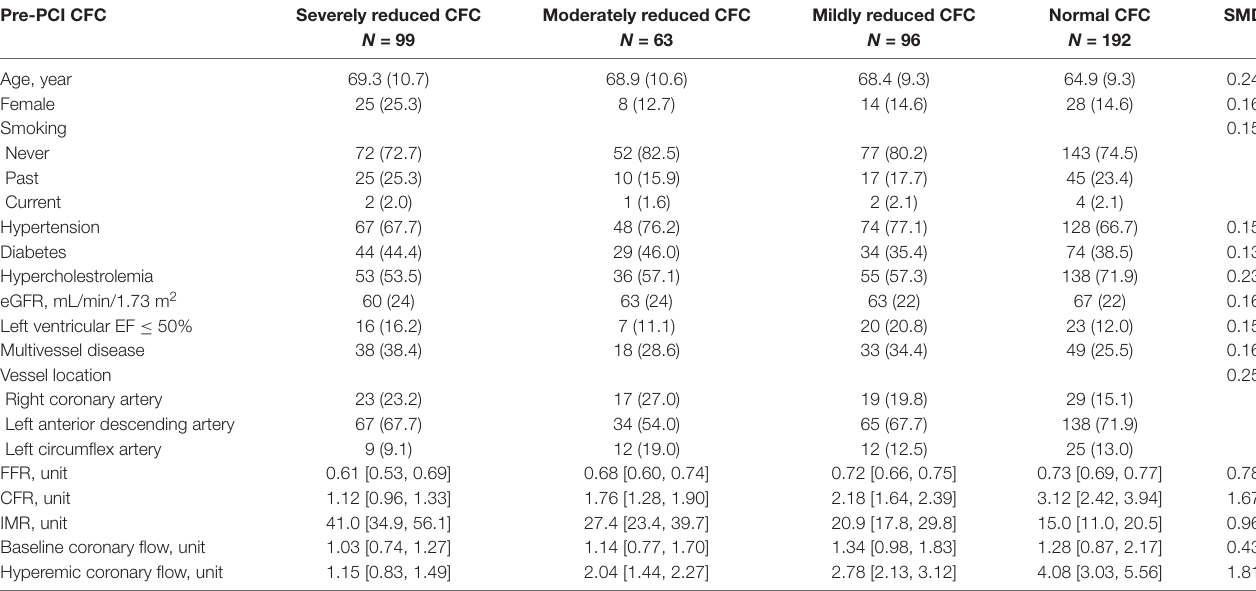
Values are n (%) for categorical variables and mean (SD) or median (IQR) for continuous variables. CFC, coronary flow capacity; CFR, coronary flow reserve; EF, ejection fraction; FFR, fractional flow reserve; IMR, index of microvascular resistance; PCI, percutaneous coronary intervention; SMD, standardized mean